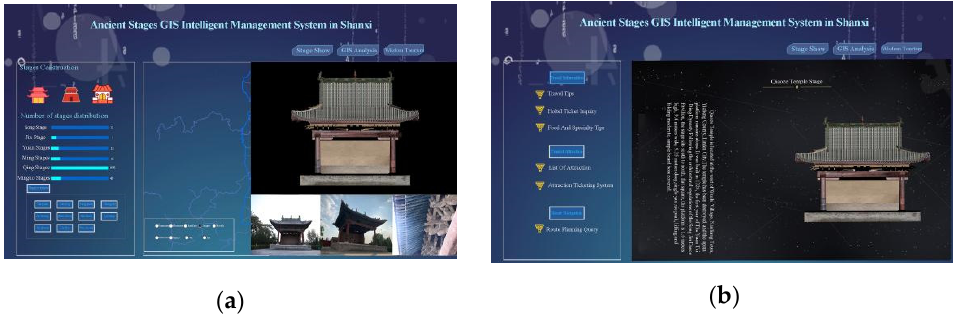
Figure 12. Stage introduction. ( a ) Browse briefly. ( b ) Explain details in interaction.